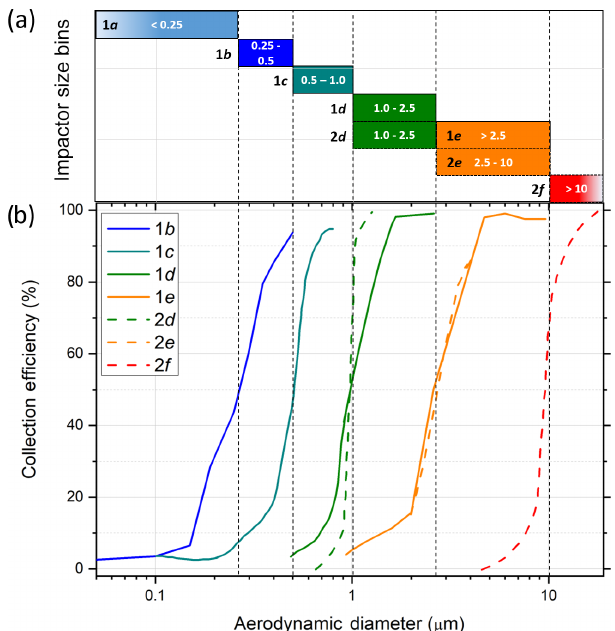
Figure 2. Collection efficiencies of each size bin of the two cas- cade impactors in the SHARK. (a) The size bins for each stage of Impactor 1 and 2 at flow rates of 9 and 100Lmin − 1 , respectively. (b) Impactor efficiency curves for each stage. Impactor 1 has four stages (1 b – e ) and one after-filter (1 a ), while Impactor 2 has three stages (2 d – f ). Stages 1 d and 2 d as well as 1 e and 2 e should be ap- proximately equivalent in terms of the aerosol size ranges